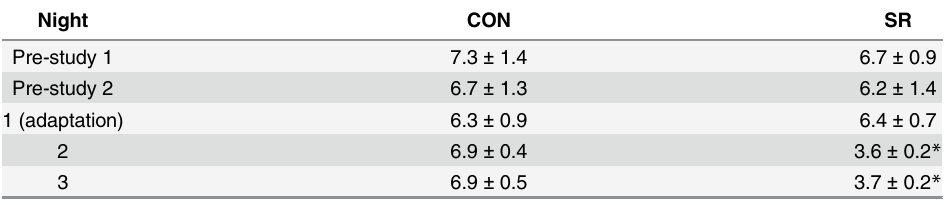
Table 2. Total sleep time (mean ± SD) for each night in both conditions